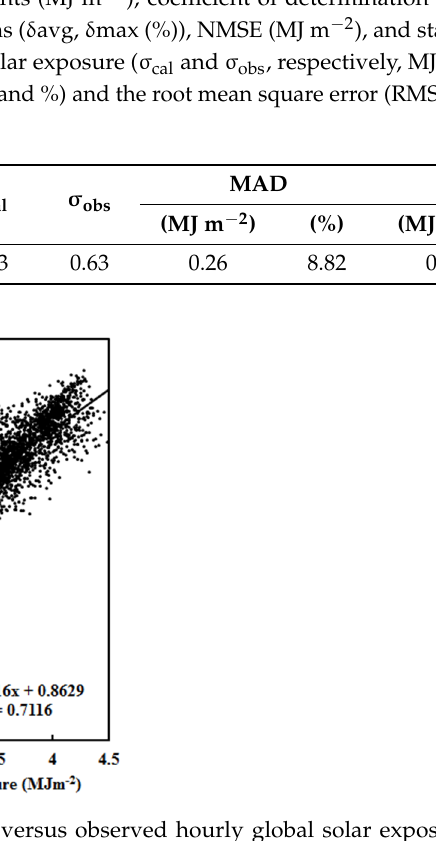
Table 1. The coefficients and constants (MJ m − 2 ), coefficient of determination (R 2 ), average and maximum of the absolute relative bias ( δ avg, δ max (%)), NMSE (MJ m − 2 ), and standard deviations of calculated and observed global solar exposure ( σ cal and σ obs , respectively, MJ m − 2 ), along with